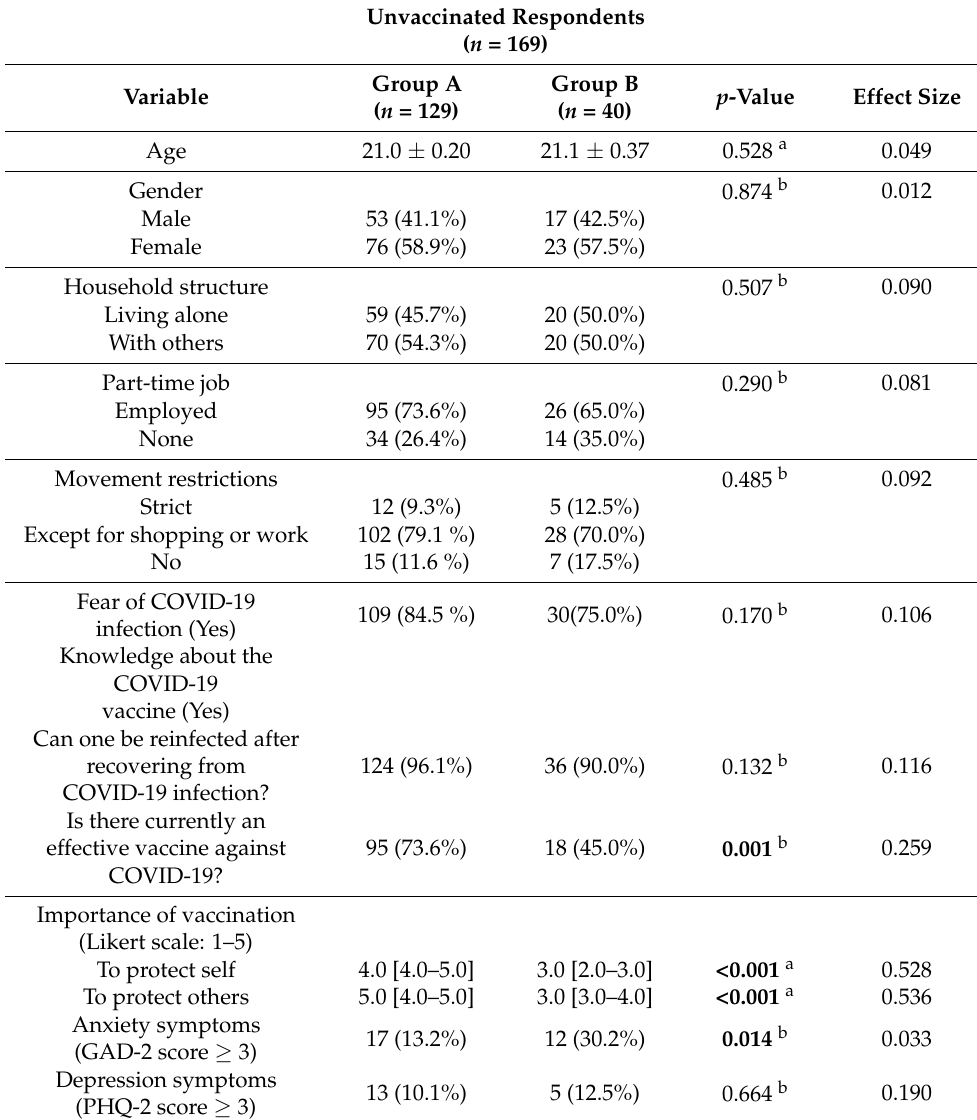
Table 2. Sociodemographic data, mental health status, and knowledge of and attitude toward COVID-19 among unvaccinated participants according to vaccination